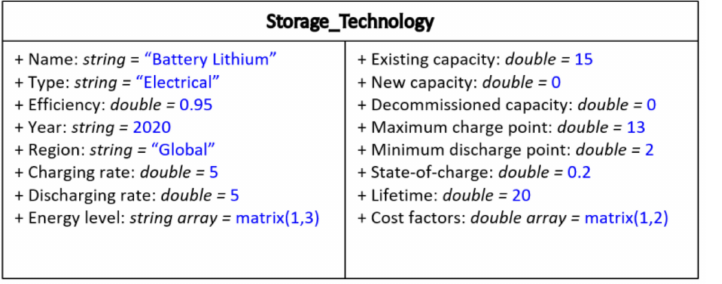
Figure 10. An example of a storage technology object, showing the assigned